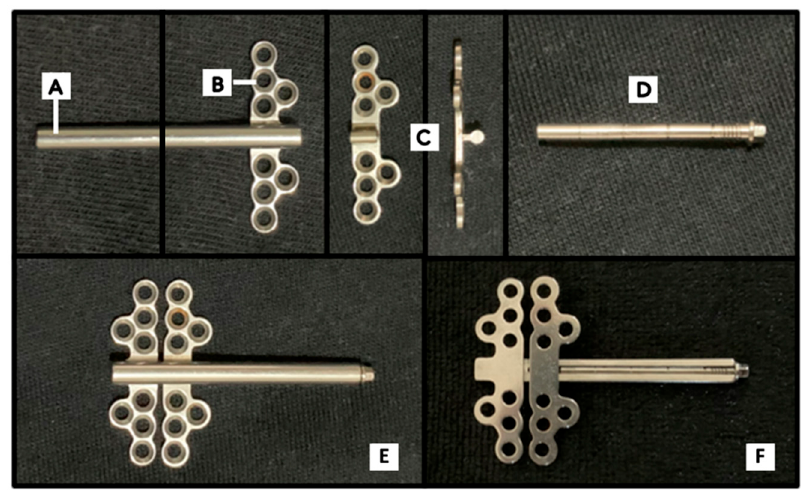
Figure 1. Components of the novel alveolar distractor: ( A ) distraction tube; ( B ) fixed base plate; ( C ) moveable base plate; ( D ) holding rod. The fully assembled distractor: ( E ) front view; ( F ) back view.